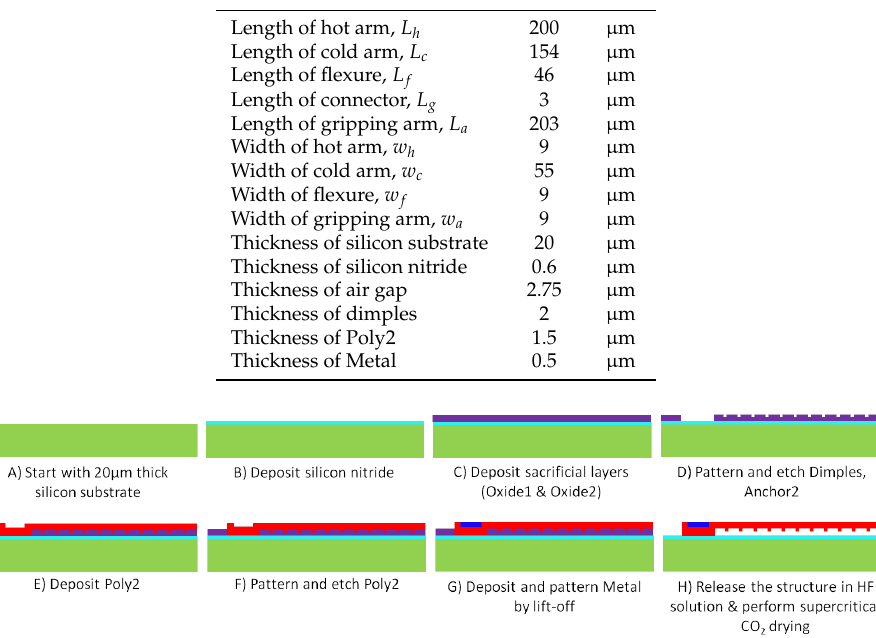
Figure 4. Schematic cross-sectional view (not-to-scale) of the PolyMUMPs TM process flow for